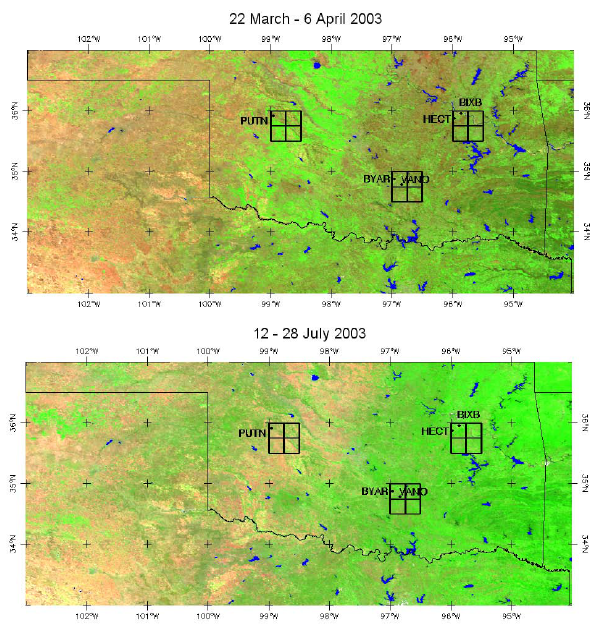
Fig. 3. RGB false colour maps (band 7, 2, and 1) of Oklahoma of 1km 16-day composite MODIS reflectance data (MCD43B4) overprinted with the Open Water Index (OWI) map for 22 March– 6 April 2003 (upper panel) and 12–28 July 2003 (lower panel). Also depicted are the three areas in the Western (PUTN), South-Central (BYAR-VANO) and Eastern Oklahoma area (HECT-BIXB). Pixels of OWI > 0 are coloured